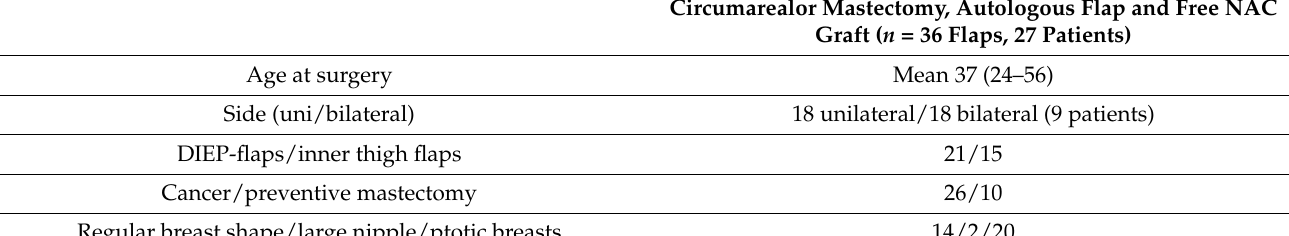
Table 1. Data of the study group.